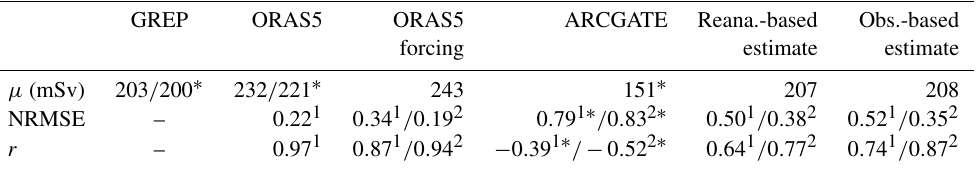
Table 8. 1993–2018 ( ∗ 2004–2010) long-term means, NRMSEs, and correlation coefficients of oceanic volume transports from GREP, ORAS5, and ARCGATE as well as estimates derived from the forcing terms used in ORAS5 (as described in Eq. 11). Additionally, our reanalyses and observation-based estimates are given. NRMSE values and correlation coefficients are calculated using monthly means with respect to GREP( 1 ) and ORAS5( 2 ). Units are milli-Sverdrup (mSv).